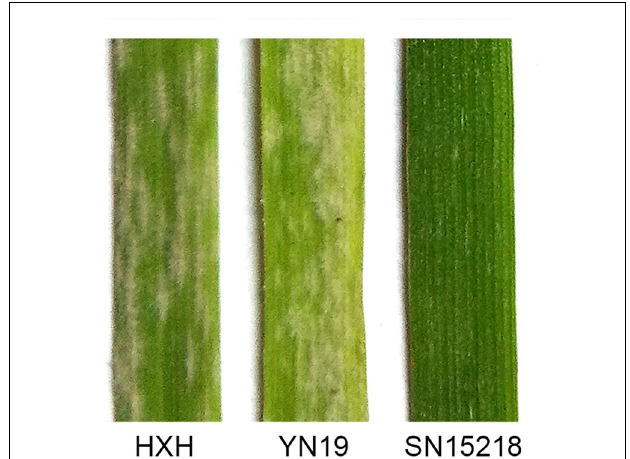
FIGURE 1 | Powdery mildew infection of seedling from susceptible materials Huixianhong (HXH), Yannong 19 (YN19), and resistant parent SN15218 at 15 dpi inoculated with Blumeria graminis f. sp. tritici ( Bgt ) isolate E09.